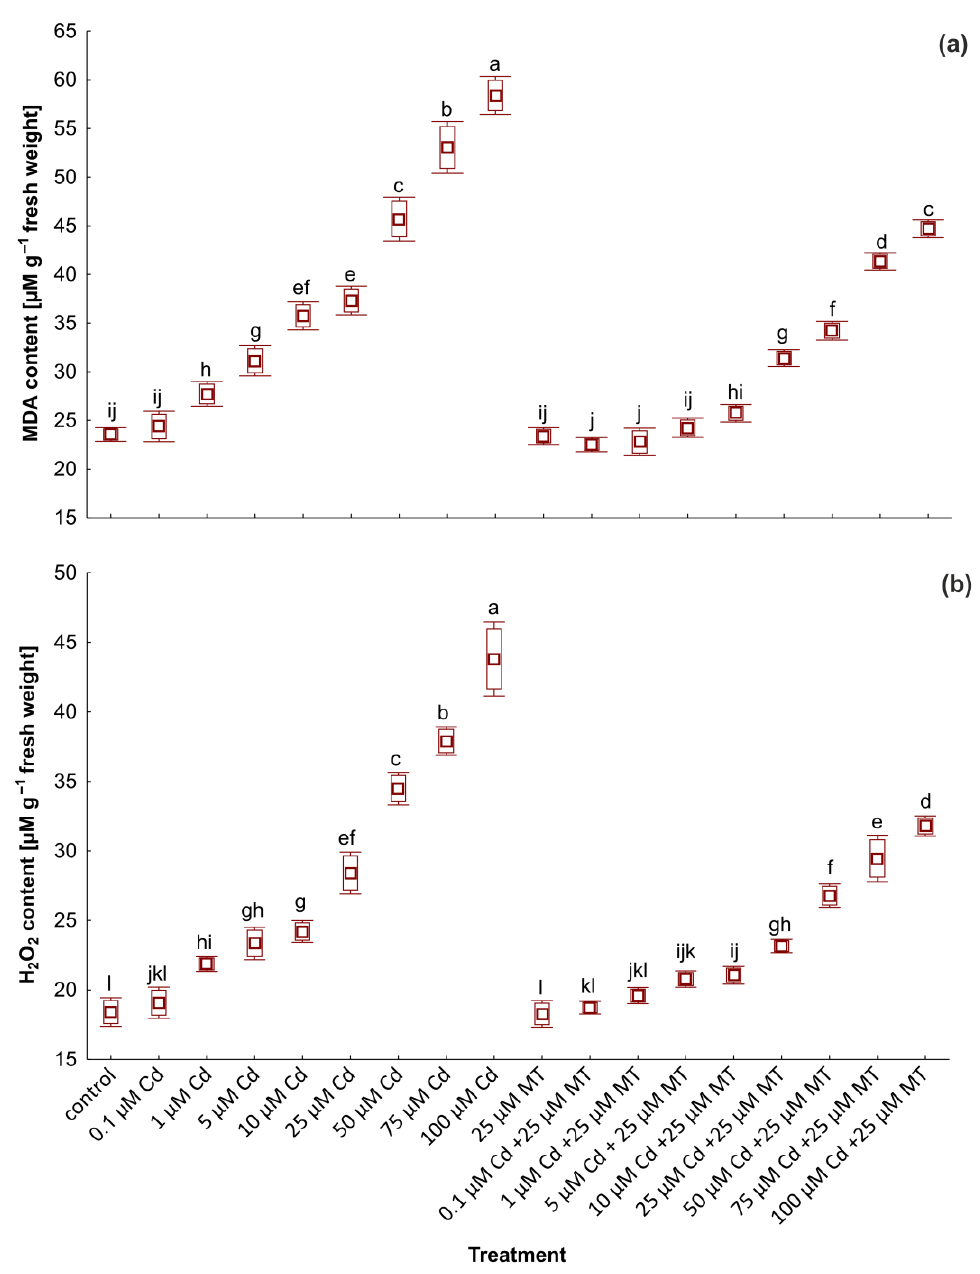
Figure 3. The content of malondialdehyde (MDA) ( a ) and hydrogen peroxide (H 2 O 2 ) ( b ) in W. arrhiza exposed to cadmium (Cd) or/with melatonin (MT) after 7 days of cultivation. The square represents the mean ( n = 5, biological replicate). The lower and upper hinges correspond to the lower and upper bounds of the 95% confidence interval of the means. The lower and upper whiskers extend from the hinge to the mean ± standard deviation. Means with the same letters are not significantly different ( p ≥ 0.05) according to Tukey’s post hoc test .